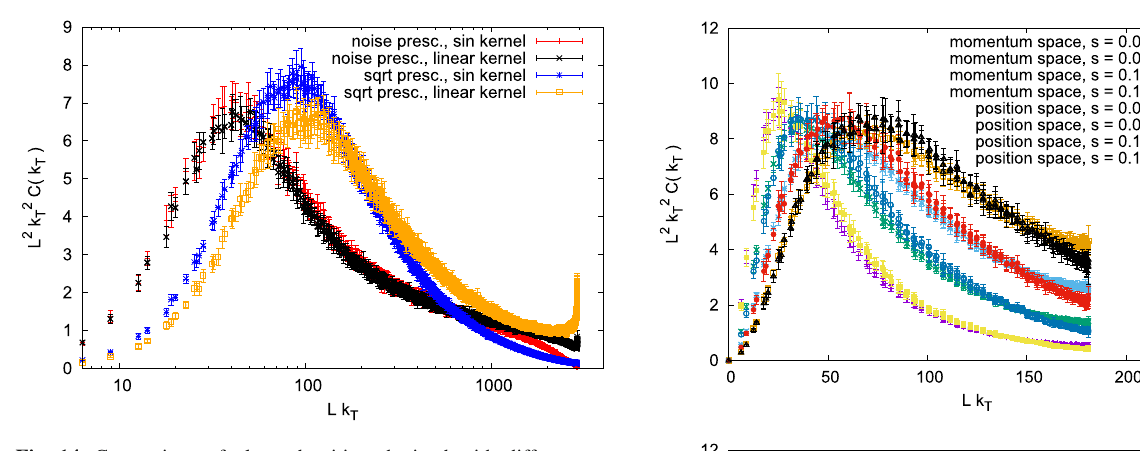
Fig. 14 Comparison of gluon densities obtained with different α S prescriptions and different kernel discretizations at s = 0 . 16 and L / a = 1024. The linear kernel shows worse behavior close to the boundary as the distribution rises for large k T . In the case of the “square root” prescription, the distortions of the linear kernel also propagate to small k T . We conclude that the linear kernel should not be used in subsequent calculations